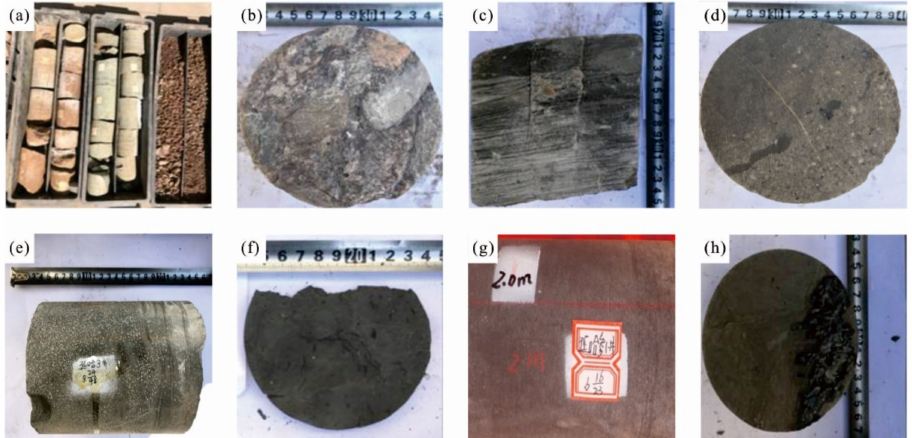
Figure 5. Core images of various reservoir types in the Hari sag. ( a ) Well Ha 2, mudstone, siltstone, K1s; ( b ) Well Ha 4, conglomerate, 2726 m, K1b; ( c ) Well Ha 2, dark fine sandstone, 1307 m, K1b; ( d ) Well Ha 4, conglomeratic sand, 1862 m, K1s; ( e ) Well Ha 2, dolomitic shale, 1599 m, K1s; ( f ) Well Ha 3, black shale, 671 m, K1y; ( g ) Well Hacan 2, 1722 m, K1s, basalt; ( h ) Well Hacan 3, mudstone